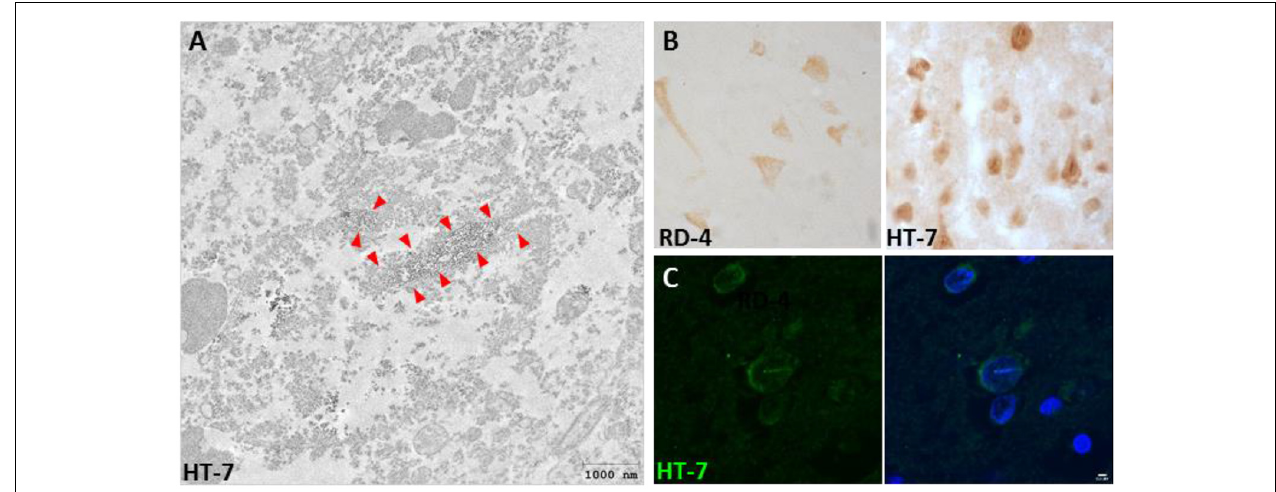
FIGURE 1 | Presence of Tau nuclear indentations (TNIs) in Huntington’s disease (HD) brains. (A) Immunoelectron microscopy analysis of HD neurons with HT-7 positive nuclear indentations. Red arrows indicate the diaminobenzidine precipitate. (B) Immunohistochemistry with RD4 and Ht-7 antibodies in neurons of HD brain. (C) HT-7 immunofluorescence (green) with DAPI (blue) counterstaining in HD striatal